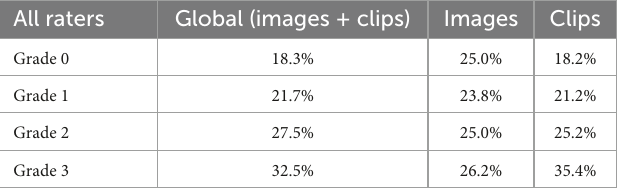
TABLE 2 Different grades of muscle echogenicity divided by images and clips as determined by the mean prevalence observed across raters. All